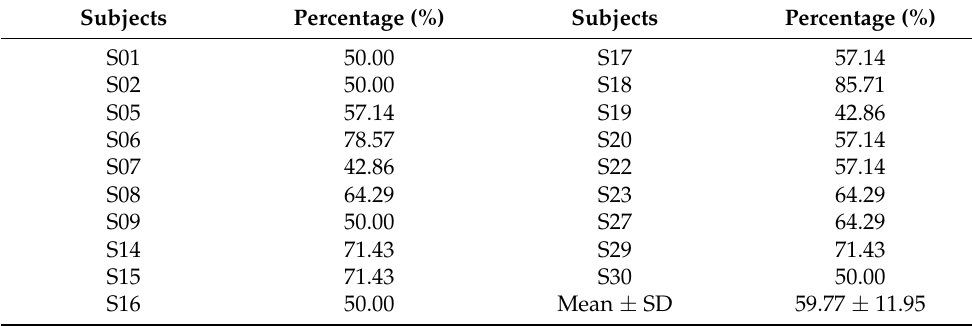
Figure 6. Color map of the differences between ME and MI tasks during the motion, open a pen. Red blocks show ERS during ME, while blue blocks represent ERS during MI. In most cases, a “follow-up” pattern—a red block followed by a blue block—can be observed, marked by the black frames. Table 3. Percentage of “follow-up” pattern in subjects at Cz among all motions.